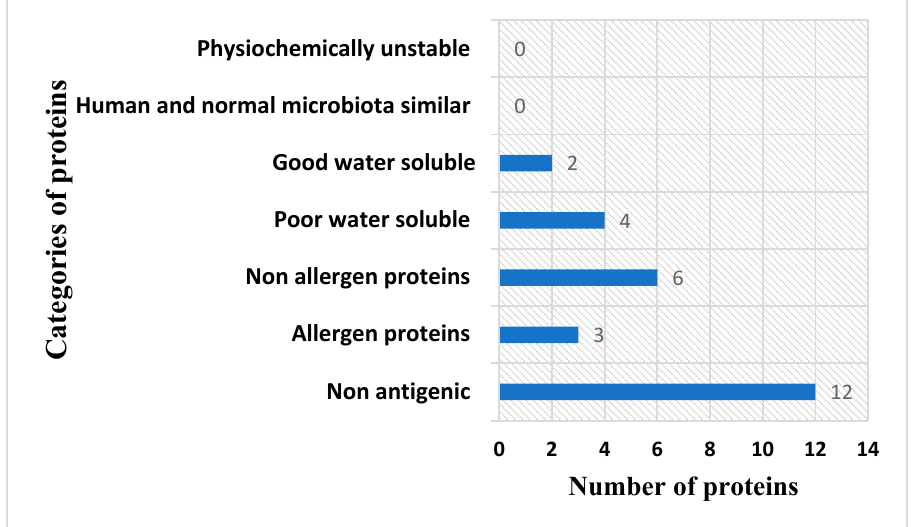
Figure 4. Vaccine target prioritization for epitope prediction. Different numbers of proteins filtered by different analyses. Table 1. Predicted B-cell epitopes from shortlisted vaccine